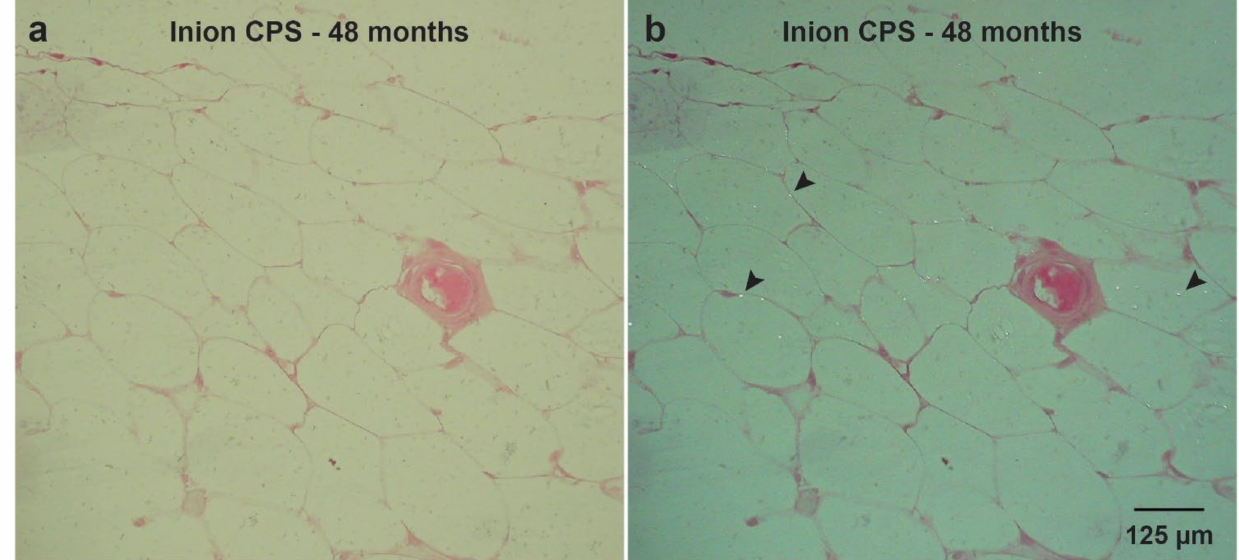
Figure 2. HE-sections of the Inion CPS system at 48-month follow-up under LM ( a ) and LM-pol ( b ) with observable residual polymer fragments (examples are indicated with black arrows). HE, hematoxylin and eosin; LM, light microscopy; LM-pol, polarized light microscopy. From the study of